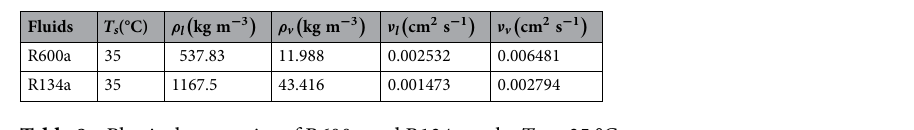
Table 8. Physical properties of R600a and R134a at the T s = 35 °C.